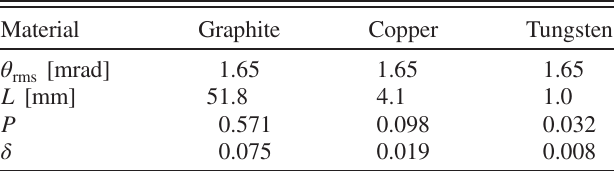
θ , thickness L , probability of rms nuclear interaction P , and momentum losses δ calculated for 40 Ar 18 þ ions at 18 Tm in the primary collimator made of graphite, copper, and